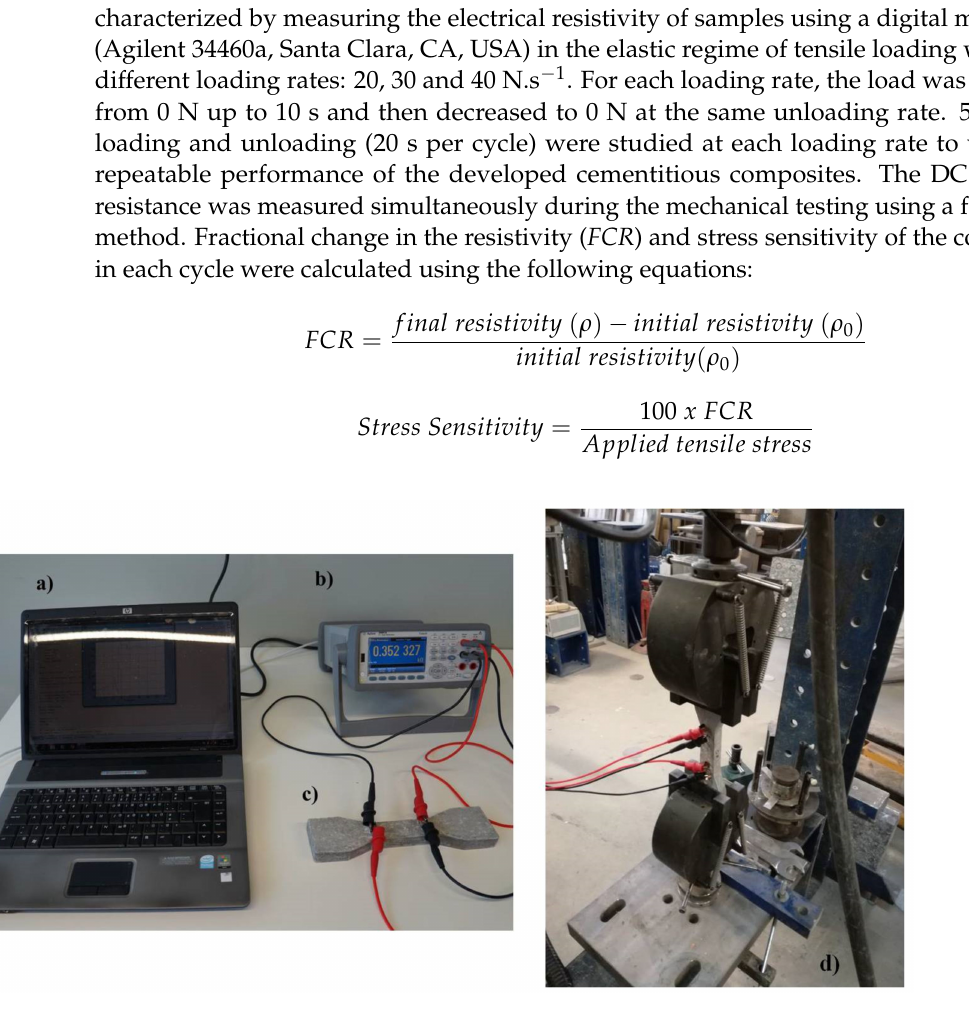
Figure 5. Measurement of ( a ) electrical resistance and ( b , c ) piezoresistive property of cementitious composites ( d ) piezoresistive property of cementitious composites in tensile